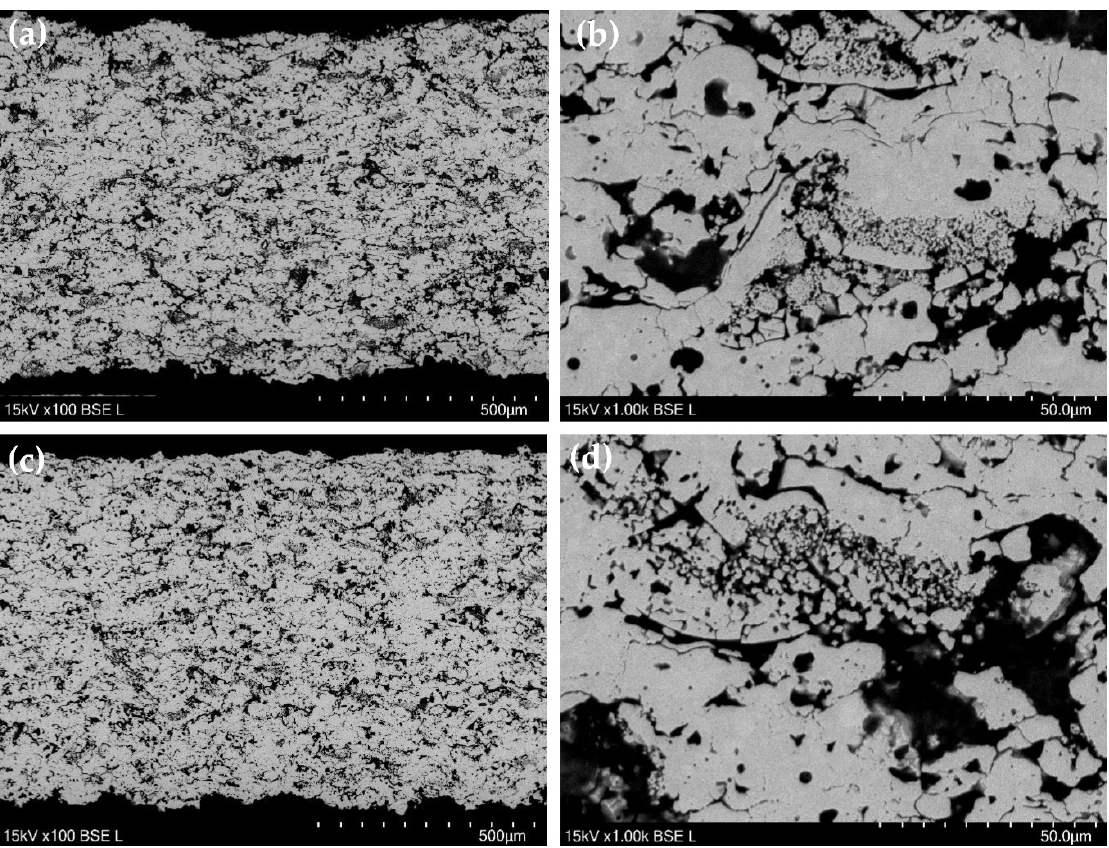
Figure 13. SEM micrographs, Low Density coating after FCT testing ( a,b ) and 400 h heat treatment ( c,d ).